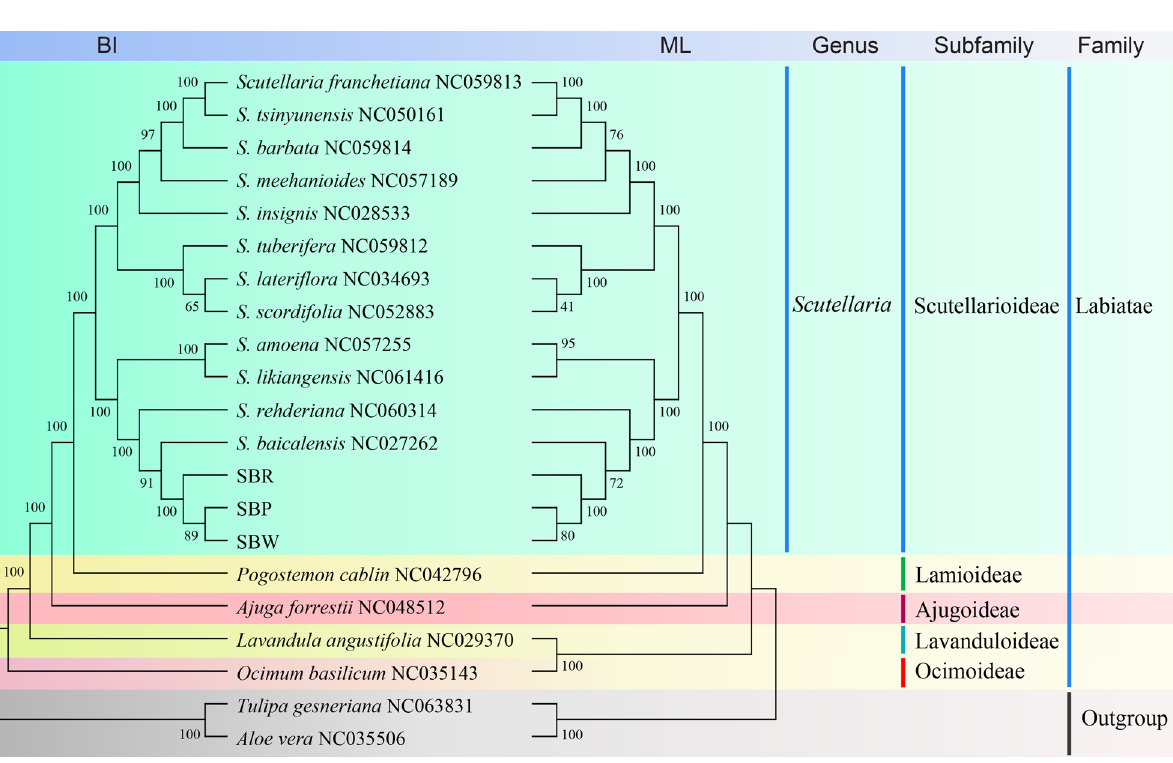
Figure 9. BI and ML phylogenetic tree based on 87 cp genes of the 21 species. The bootstrap support values are listed at each